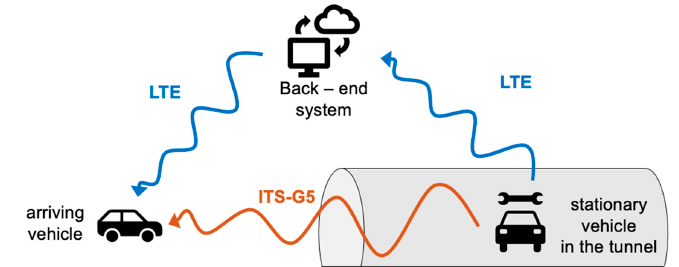
Figure 5. Schema of the major test